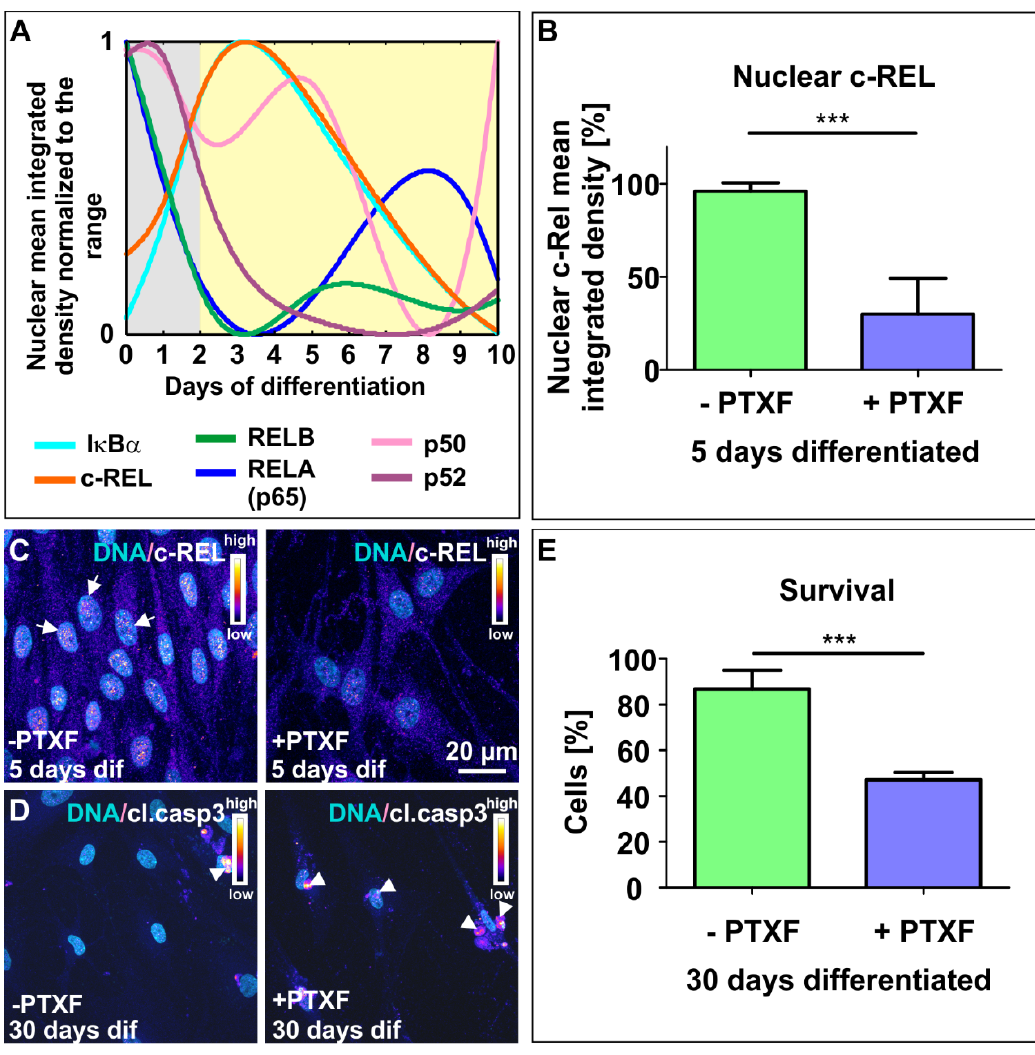
Figure 2. NF- κ B subunit composition in early glutamatergic differentiation and c-REL potential function. ( A ) NF- κ B subunit distribution in early stages of glutamatergic differentiation. Nuclear mean integrated density illustrated by fitting a polynomial function of the individual data normalized by the range of the median, showing each of the NF- κ B subunits, as indicated by colors. ( B ) Quantified c-REL nuclear mean integrated density ( n = 3, mean ± SEM). Nonparametric Mann Whitney test confirmed a significant decrease in nuclear c-REL after 5 days of differentiation with PTXF (*** p ≤ 0.0001), a known c-REL inhibitor. ( C ) 5 days differentiated NCSC-derived NSCs in the absence or presence of PTXF, labeled against c-REL shown by intensity scale and DNA colocalization. Arrows depict c-REL nuclear activation. ( D ) NCSC-derived NSCs differentiated in the absence or presence of PTXF for 30 days, labeled against cleaved-caspase-3 (cl.casp-3, intensity scale) showing DNA colocalization. Arrowheads depict dead cells. ( E ) Survival quantified for NCSC-derived NSCs differentiated in the absence or presence of PTXF for 30 days ( n = 3, mean ± SEM). Nonparametric Mann Whitney test confirmed a significant decrease in survival PTXF-treated (*** p ≤ 0.001) compared to untreated neurons. PTXF: pentoxifylline, NCSCs: neural crest-derived stem cells, NSCs: neural stem cells.